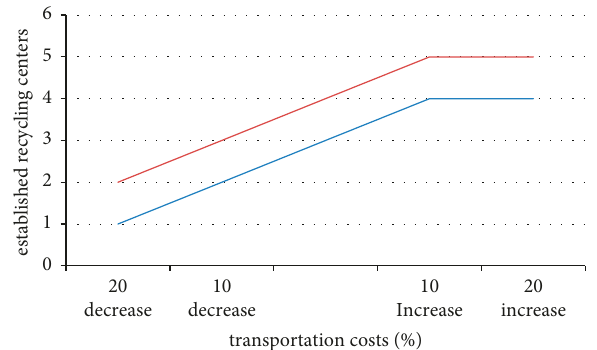
Figure 7: Sensitivity analysis of the number of established recycling centers relative to transportation